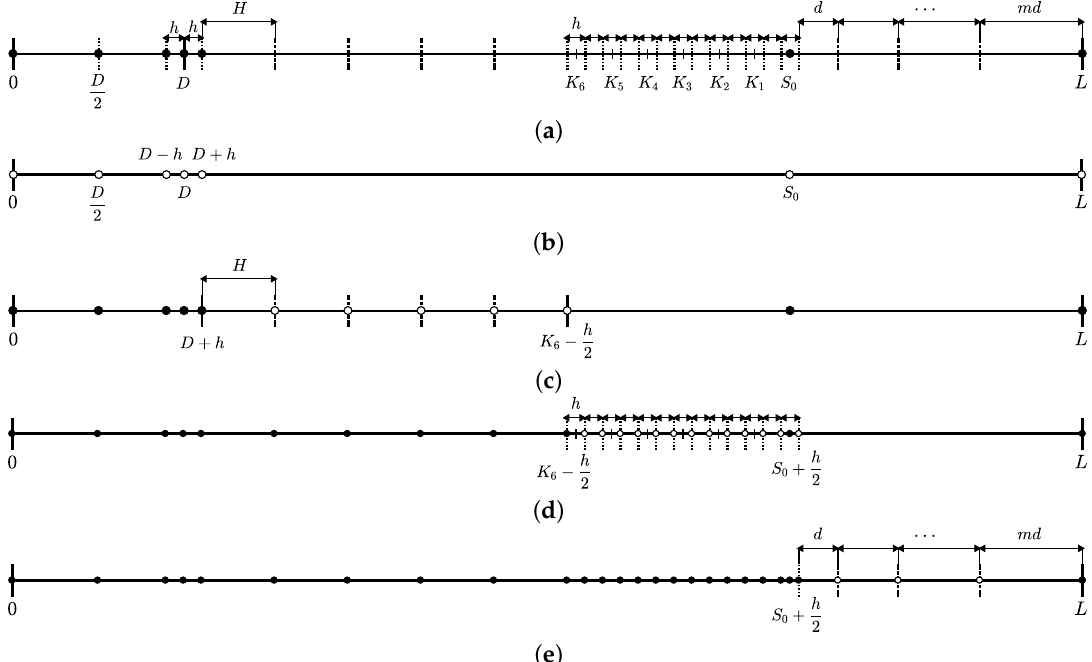
Figure 5. ( a ) Schematic illustration of the suggested grid Ω x = Ω 1 ∪ Ω 2 ∪ Ω 3 ∪ Ω 4 . ( b – e ) are schematic illustrations of Ω 1 , Ω 2 , Ω 3 , and Ω 4